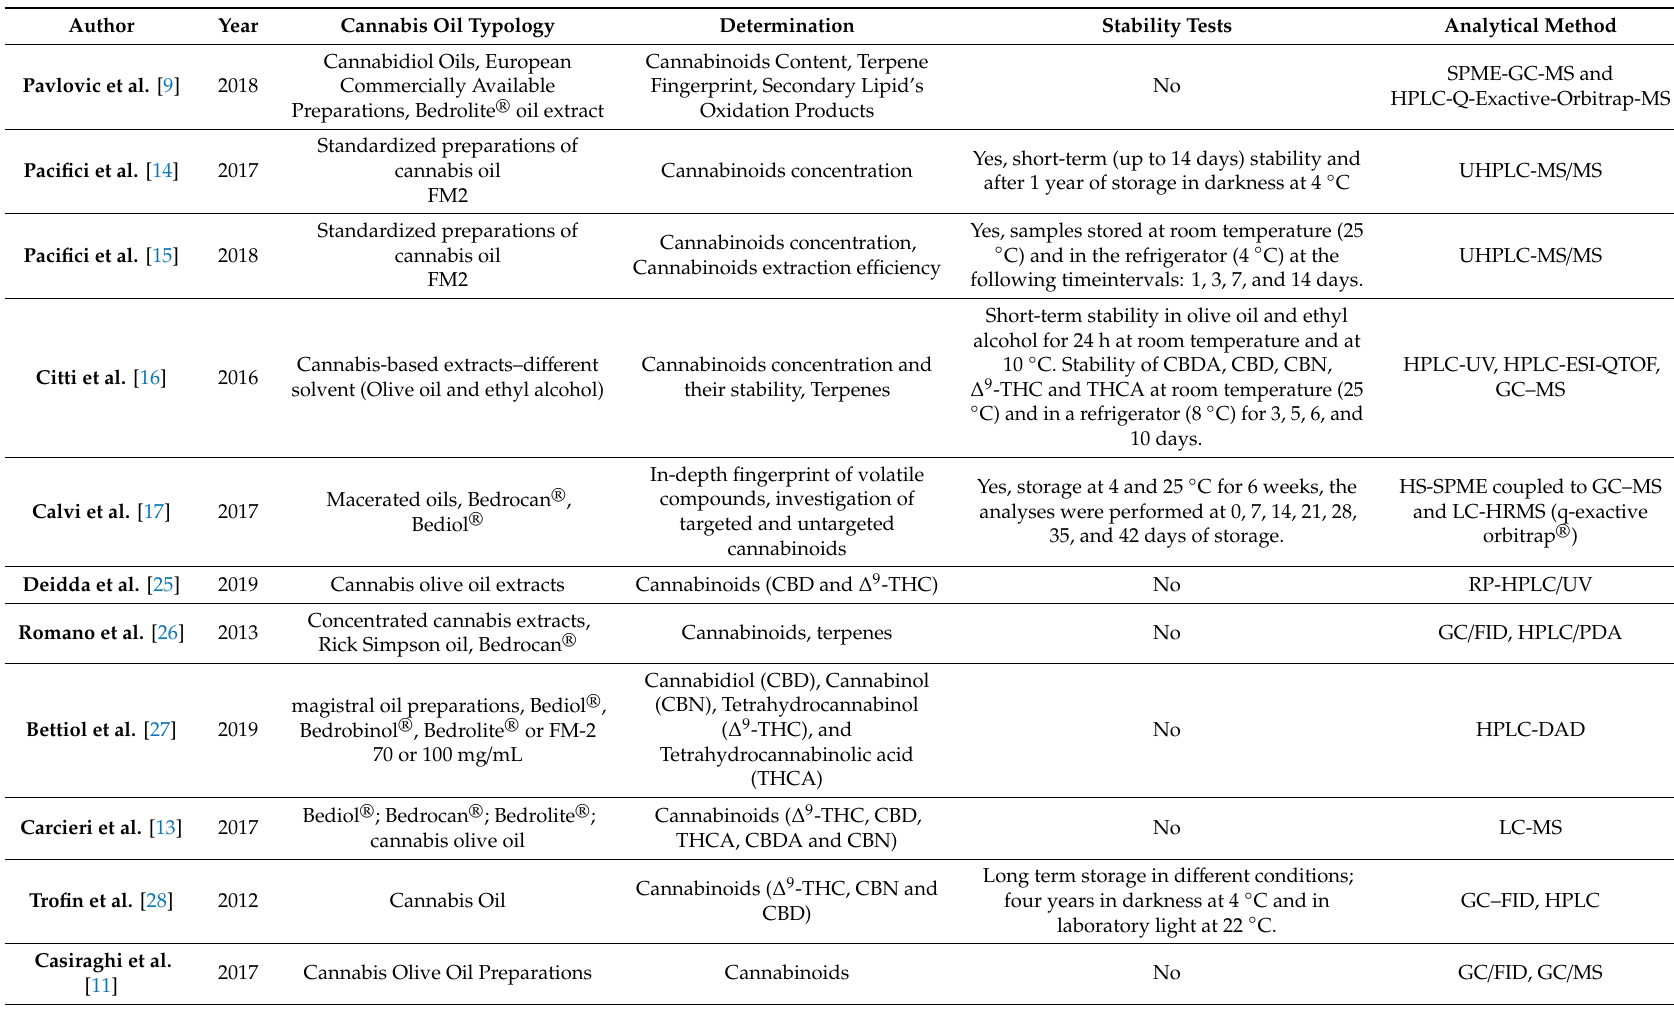
Table 1. Research investigation on cannabis-based oily